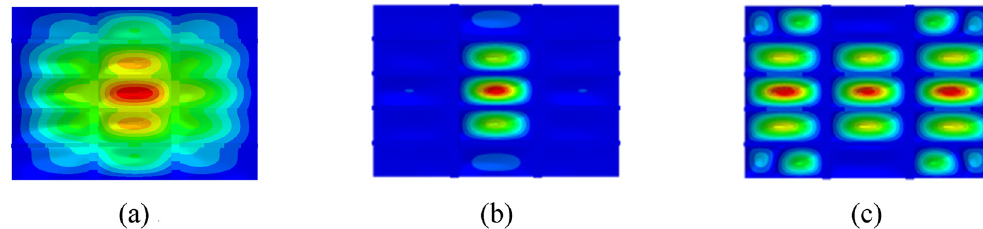
Figure 15: Vibration velocity response diagram of uniform distribution excitation: ( a ) 53 Hz, ( b ) 97 Hz, and ( c ) 103 Hz.